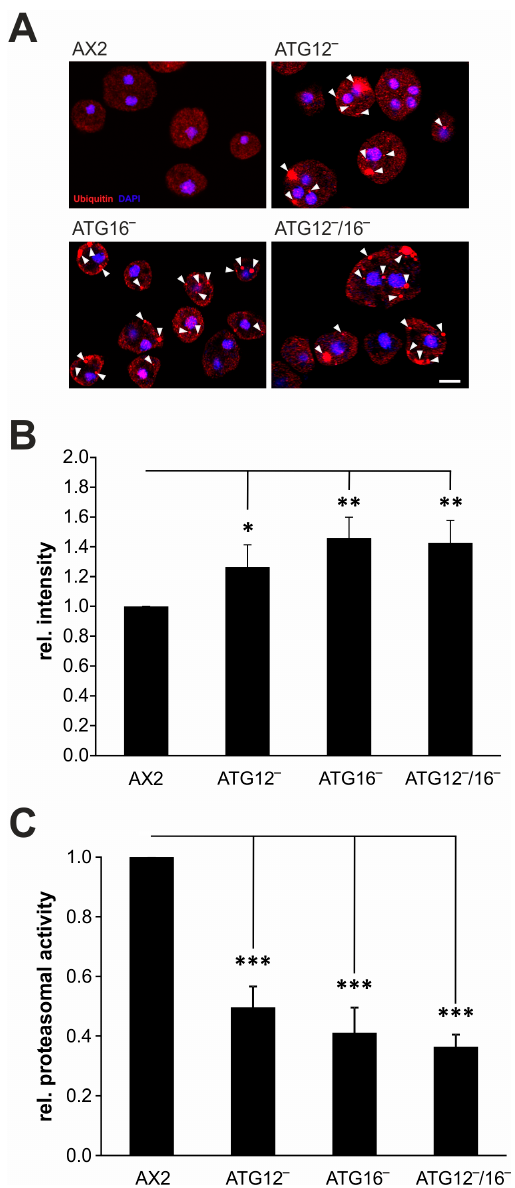
7 Figure 7. Protein homeostasis is disturbed in the knock-out strains. ( A ) Immunofluorescence microscopy of AX2, ATG12 − , ATG16 − , and ATG12 − /16 − cells. Cells were fixed with cold methanol and stained with the mAb P4D1. Large ubiquitin-positive protein aggregates in mutant strains are marked by arrowheads. Nuclei were visualized by DAPI staining. The scale bar is 5 µ m. ( B ) Quantification of global protein ubiquitination. The P4D1 signal intensities of five blots were quantified and normalized with the actin signal. The signal intensity of AX2 was set to 1. For statistical analysis the Dunn-Bonferroni test was used as post hoc analysis. ** p ≤ 0.01; * p ≤ 0.05. ( C ) Proteasomal activity of AX2 and knock-out strains. The proteasomal activity assay was conducted as described [32]. The specific proteasomal activity was calculated by normalization with the amount of proteasomal subunit psmA7 (SU7) expression as shown in Figure S5B. The chymotrypsin-like activity of AX2 was set to 1. Three independent experiments were performed and mean values and SEM calculated. For statistical analysis Tukey’s test was used as post hoc analysis. *** p ≤